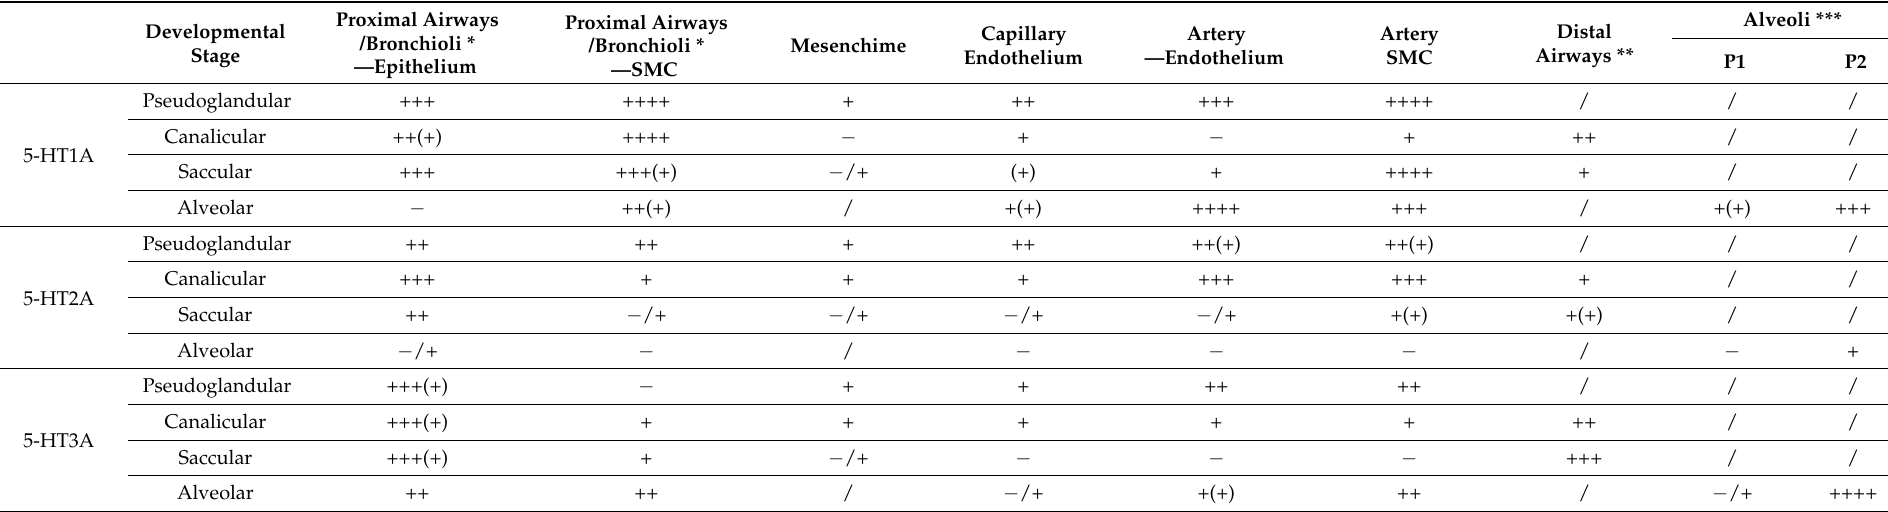
* Proximal airways at pseudoglandular, canalicular, and saccular stages, bronchioles at alveolar stage; SMC—smooth muscle cells; ** only at pseudoglandular, canalicular, and saccular stages; *** alveolar stage; P1—type I pneumocytes; P2—type II pneumocytes. The intensity of staining in different lung structures was evaluated semiquantitatively according to